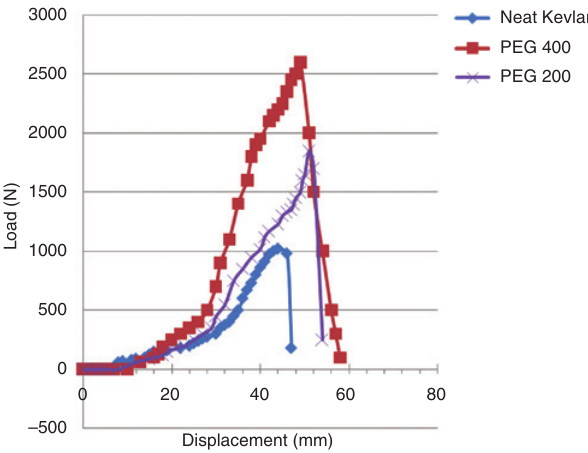
Figure 12: Load-displacement curve of the 15 wt% silica samples in PEG 200 and PEG 400.